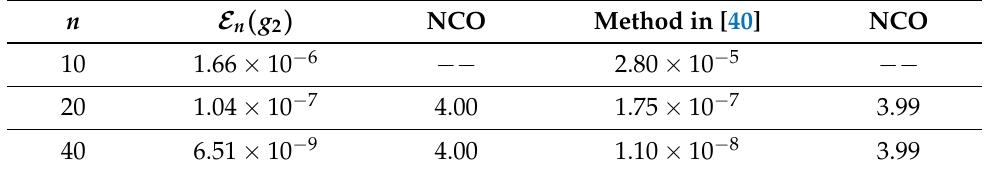
Table 3. Estimated errors for function g 2 , and NCOs with different values of n .